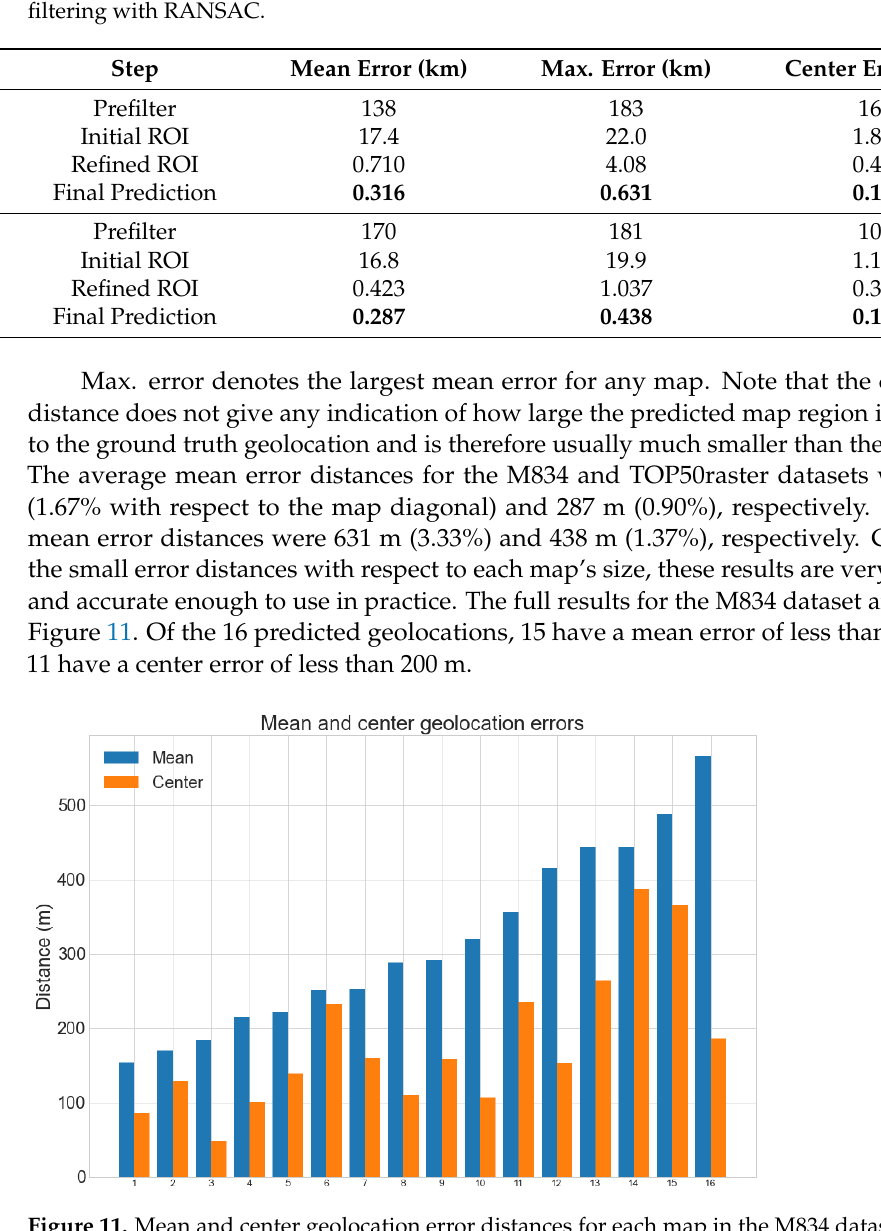
Figure 11. Mean and center geolocation error distances for each map in the M834